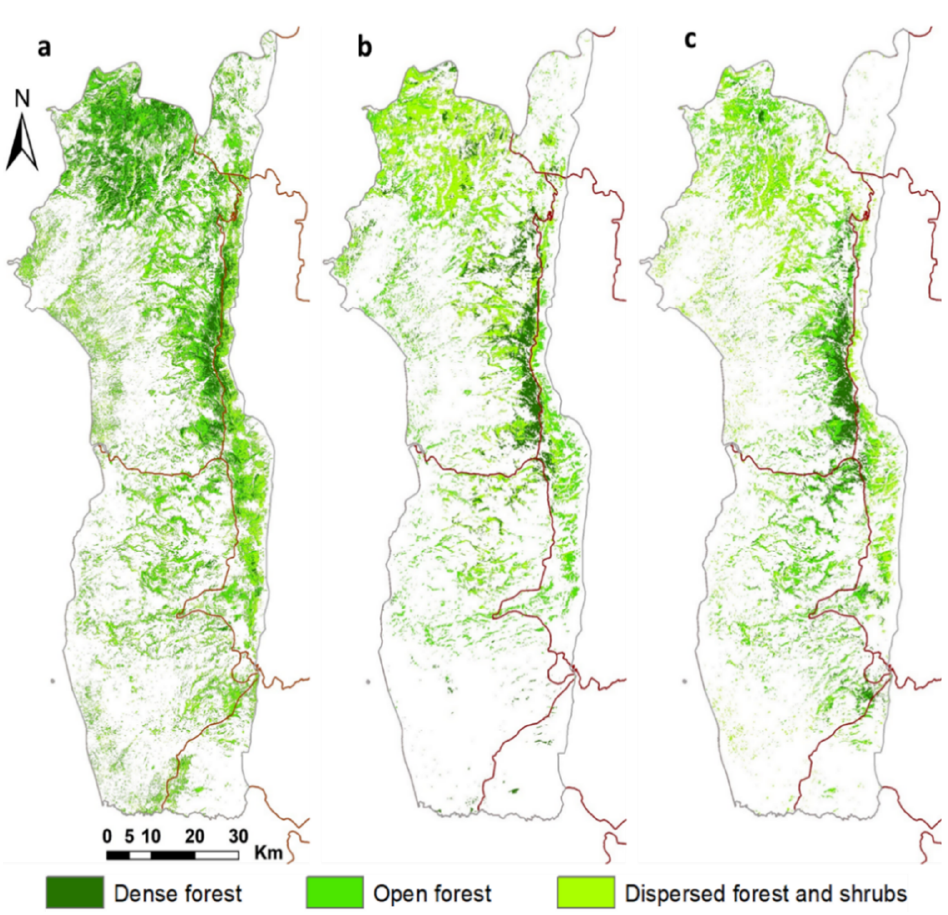
Figure 7. Changes in forest cover density in the study area for 2010 ( a ), 2015 ( b ), and 2020 ( c ).